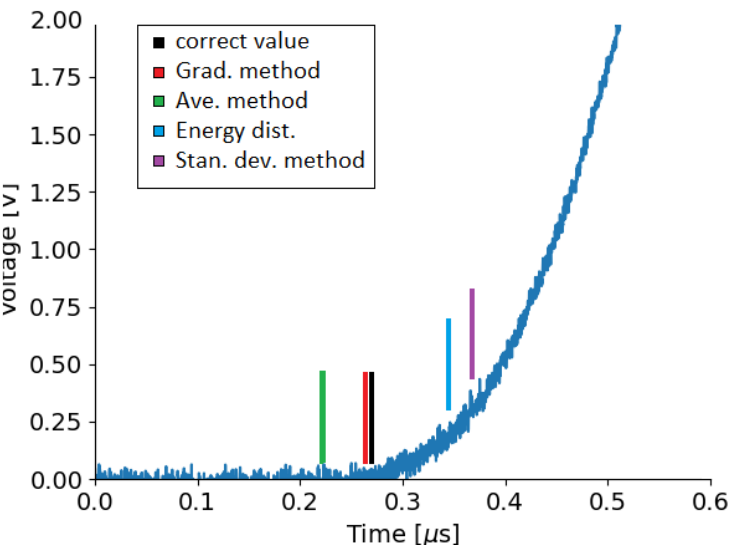
Figure 5. The point determined as the shortest time-of-flight (maximum proton energy) for codes original simplified methods compared to the newly designed algorithms for a single training dataset (Figure 3 shot 1). Table 1. Gradient-method calculated predictions of shortest time-of-arrival and corresponding max. proton energies for a number of the training datasets, along with the corresponding equivalent en- ergies. Shots arranged in order of decreasing S/N ratio. The accuracy was calculated from the devi- ation between estimate and algorithm answers as a percentage of full dataset size.